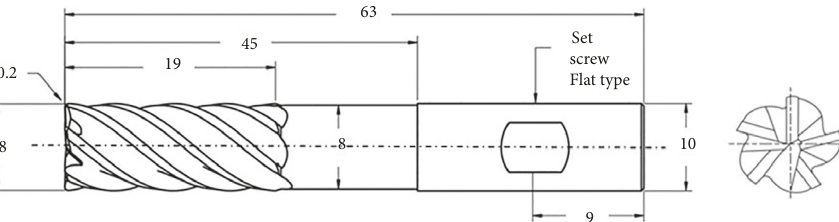
Figure 3: Cutting tool dimensions.